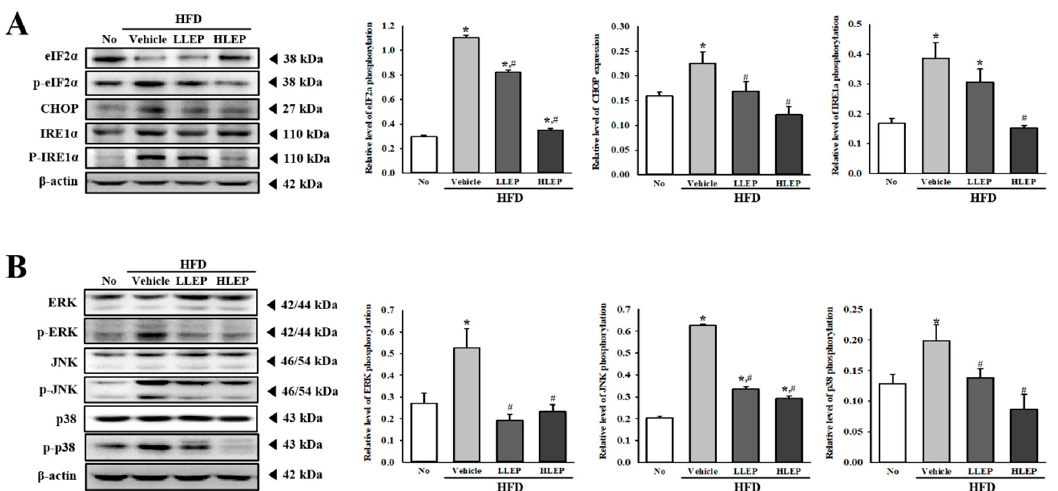
Figure 5. Expressions of key marker proteins for ER stress and MAP kinase signaling pathway in liver tissue. ( A ) The expression levels of ER stress markers, including eIF2 α , p-eIF2 α , CHOP, p-IRE1 α and IRE1 α , were detected in total liver proteins using specific antibodies. ( B ) Using specific antibodies, the expression levels of ERK, p-ERK, JNK, p-JNK, p38, and p-p38 in the MAPK signaling pathway were detected in total liver proteins. The band intensity of proteins was determined using an imaging densitometer, and the level of each protein was calculated based on the intensity of actin protein as an endogenous control. After then, the phosphorylation level of specific protein was calculated by dividing the level of phosphorylated proteins by the level of total proteins. Three to five mice per group were used in the preparation of tissue homogenate, and Western blot analysis was assayed in duplicate for each sample. Data represent the mean ± SD. * p < 0.05 compared to the No-treated group. # p < 0.05 compared to the HFD + Vehicle-treated group. Abbreviations: HFD, high-fat diet; LLEP, low concentration of LEP; HLEP, high concentration of LEP; ER, Endoplasmic reticulum; MAP; mitogen-activated protein; CHOP, C / EBP homologous protein, eIF2 α , eukaryotic translation initiation factor 2 α ; IRE1 α , inositol-requiring protein 1 α .